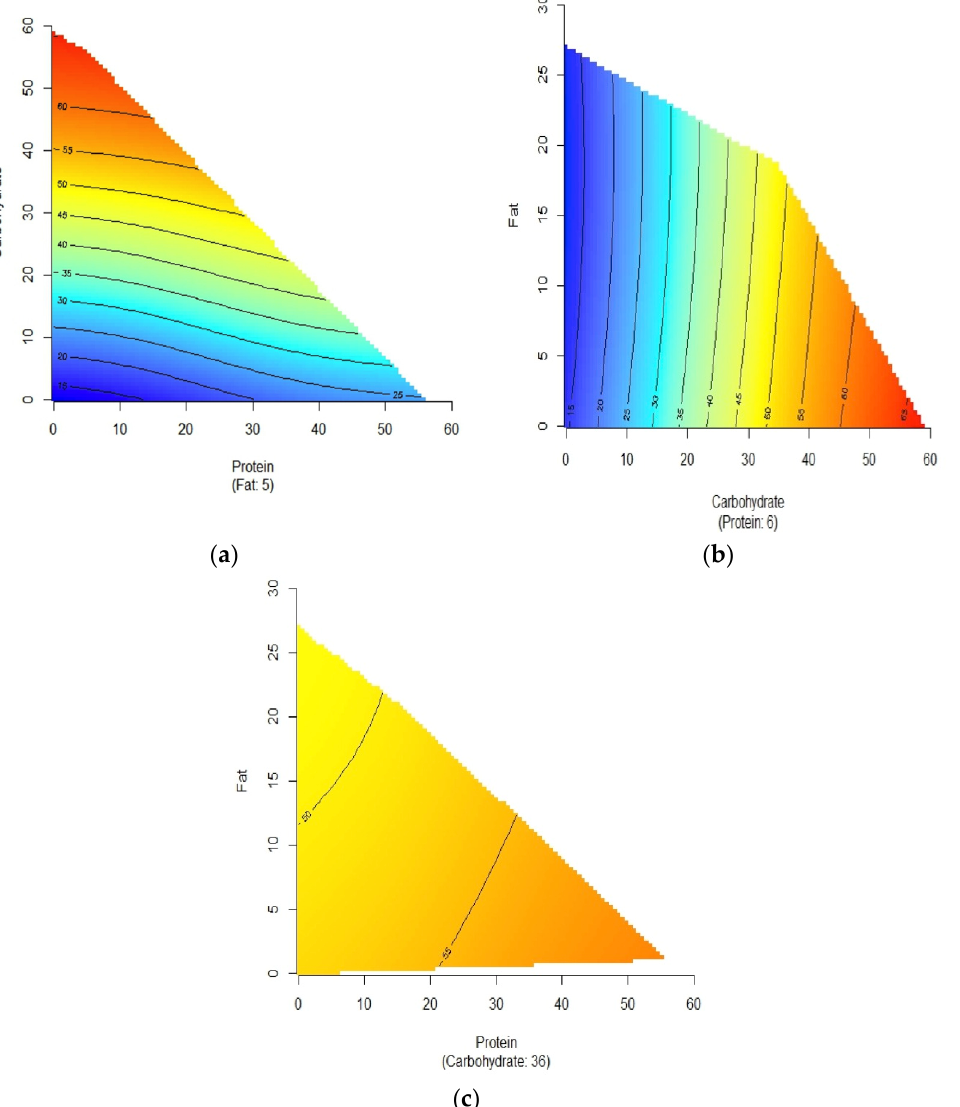
Figure 2. ( a – c ) The colour ‐ coded profiles show the relationship between carbohydrate (g/1000 kJ), protein (g/1000 kJ) and fat (g/1000 kJ) and the Food Insulin Index (FII) values of common foods. The isolines for FII rise in elevation from dark blue to dark red. For each profile, the third macronutrient is held constant at the median level, that is 5 g of fat/1000 kJ (Figure 2a), 6 g of protein/1000 kJ (Figure 2B) and 36 g of carbohydrate/1000 kJ (Figure 2c).